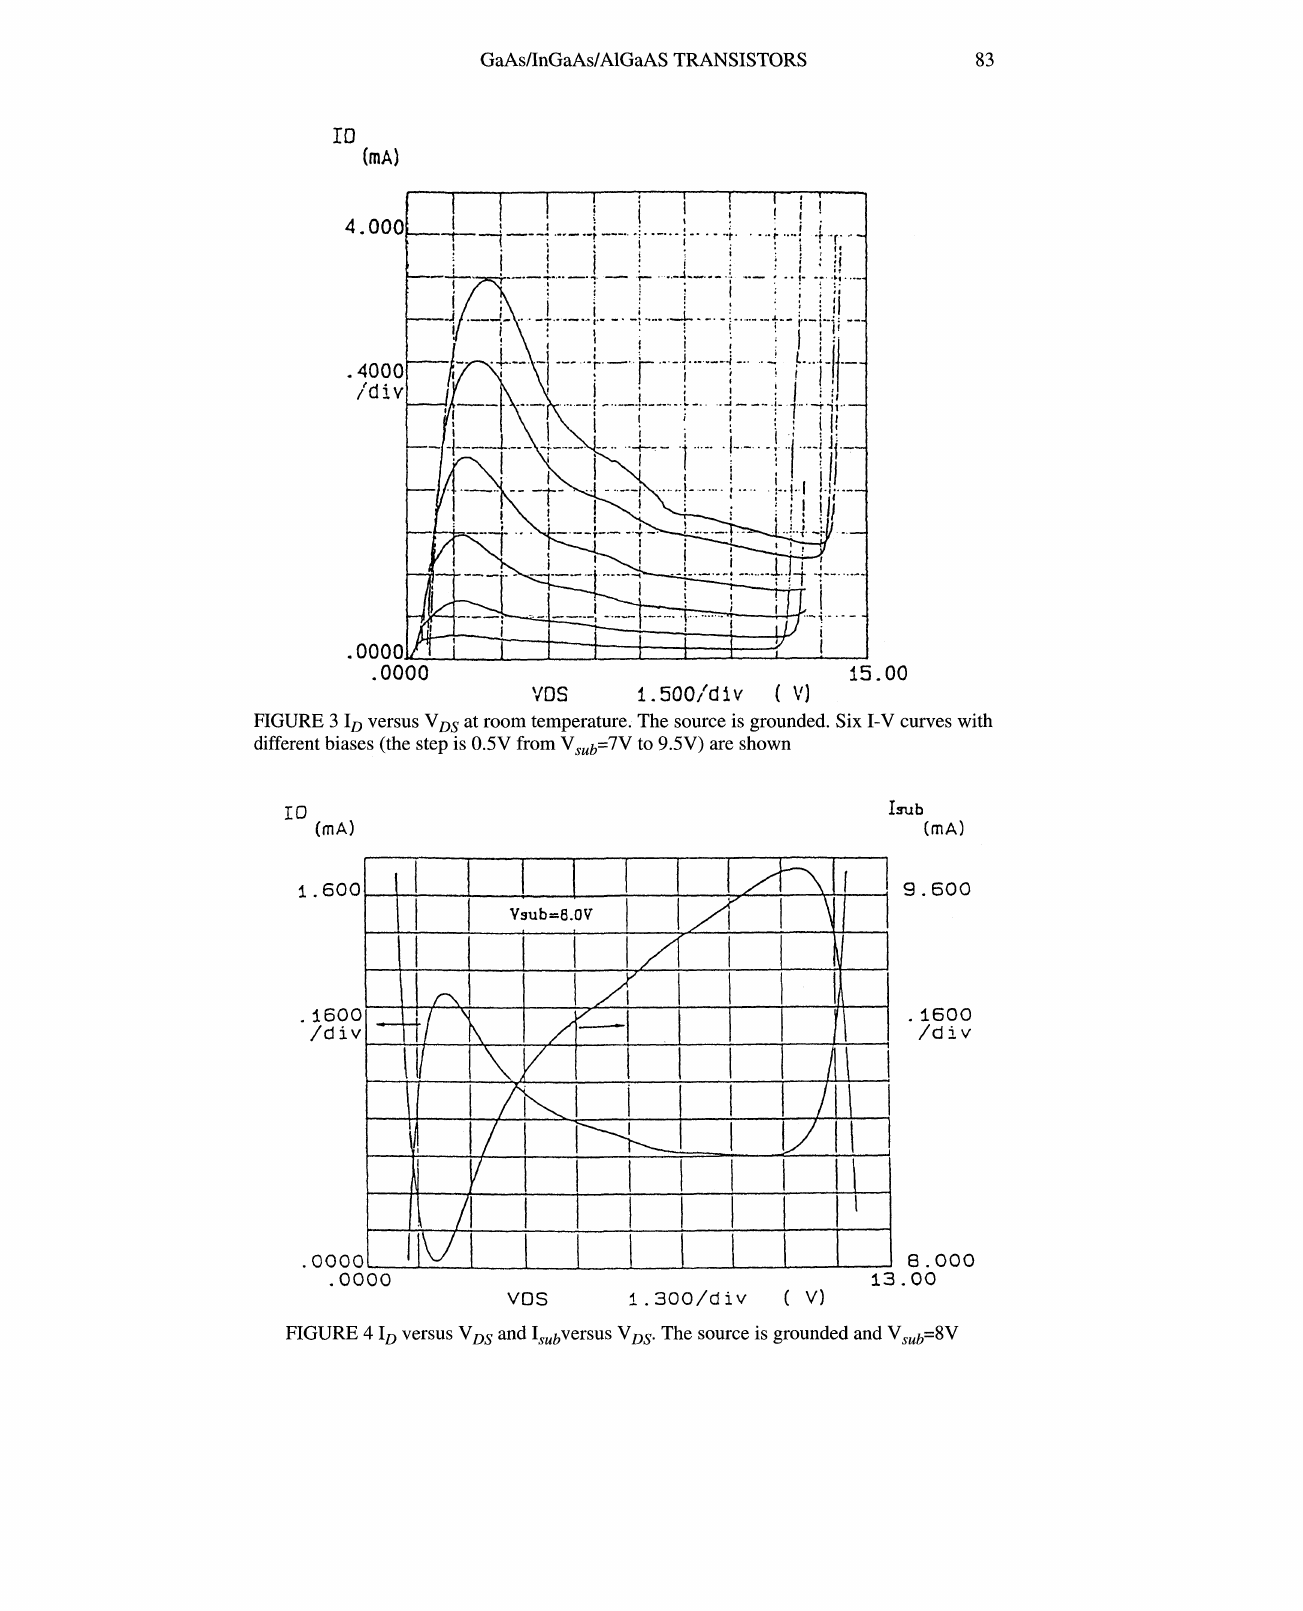
FIGURE 4 1D versus VDS and Isu/versus VDS. The source is grounded and